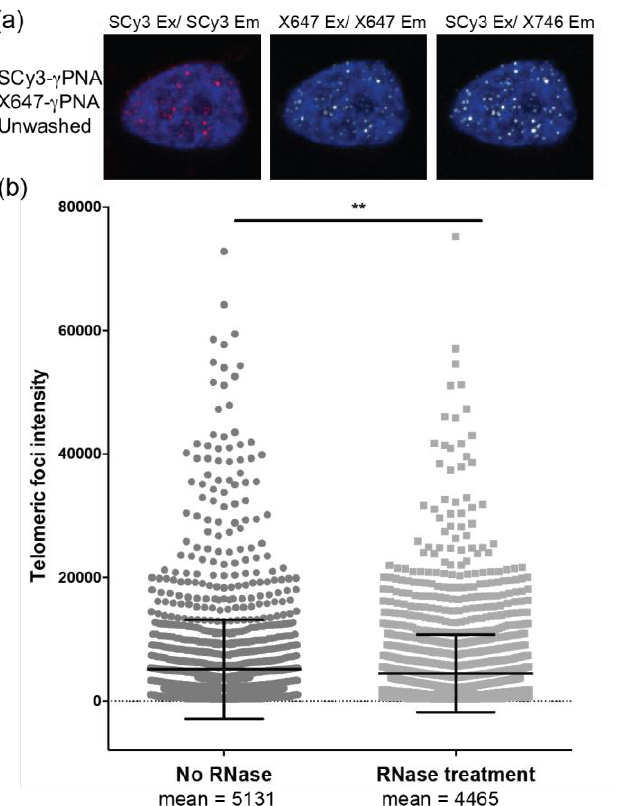
Figure 5. FRET pair miniprobes stain telomeres in human cells with critically short telomeres. ( a ) Interphase HeLa VST cell nuclei were stained with a mix of SCy3-γPNA and X647-γPNA probes (1:1 ratio) by FISH in the absence of washings, and without (shown) or with RNase treatment. Images were captured using filters for SCy3 excitation and emission (red), X647 excitation and emission (white) or SCy3 excitation and X647 emission (white, FRET channel); ( b ) Fluorescence signal intensity was measured for each telomeric foci in the FRET channel. Data from 60 nuclei, each for no RNase ( n = 1822 foci) and RNase treatment ( n = 2271), are from two independent experiments. Mean and SEM from total foci are shown. ** p = 0.0029, unpaired t -test.